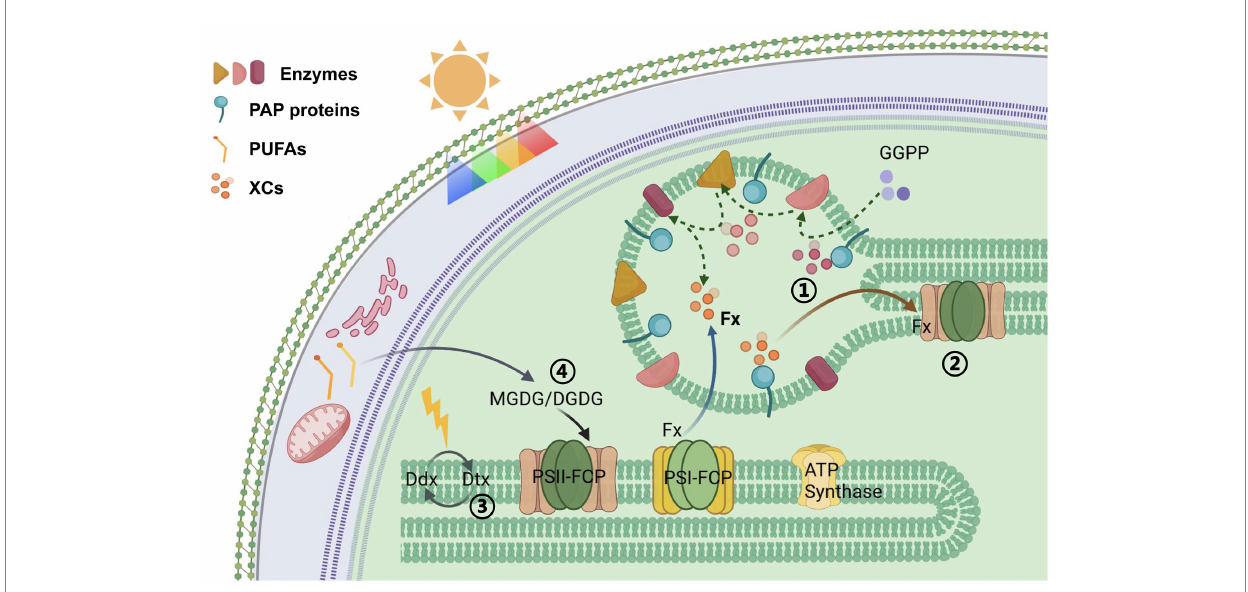
FIGURE 6 Schematic overview of proposed organization: Overexpression of the PAP gene (1) led to the accumulation of xanthophylls in PGs, (2) affected the assembly of photosynthetic system antenna proteins, (3) reduced the efficiency of XC in thylakoids, (4) increased the degree of unsaturation of MGDG and DGDG in thylakoid membranes, thereby enhancing membrane